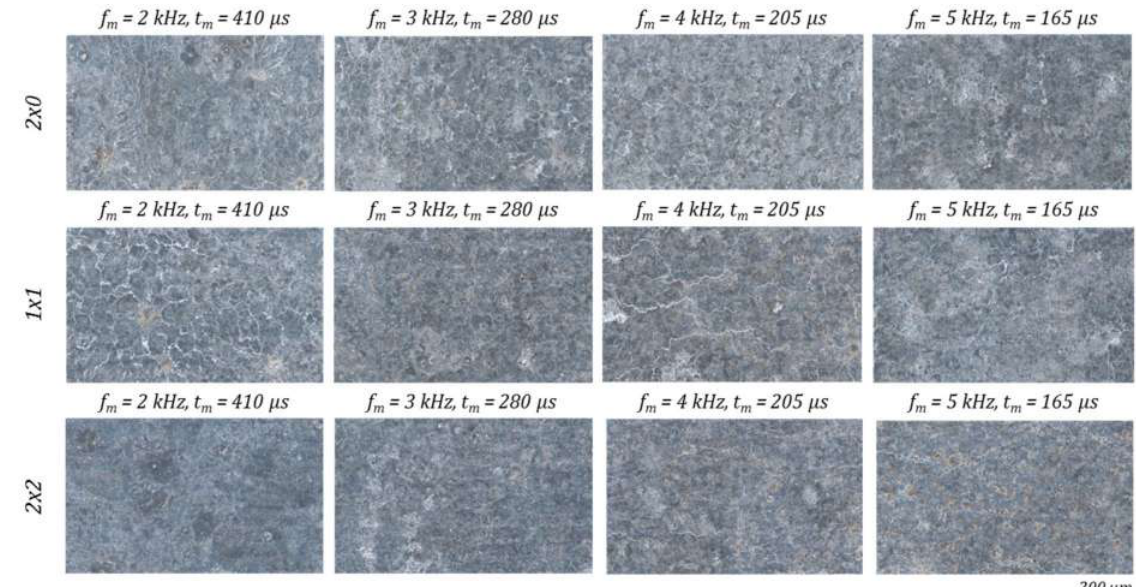
Figure 24. Microscopic differences at a 100-fold magnification of the achieved surface topography after laser polishing with multiple polishing passes.